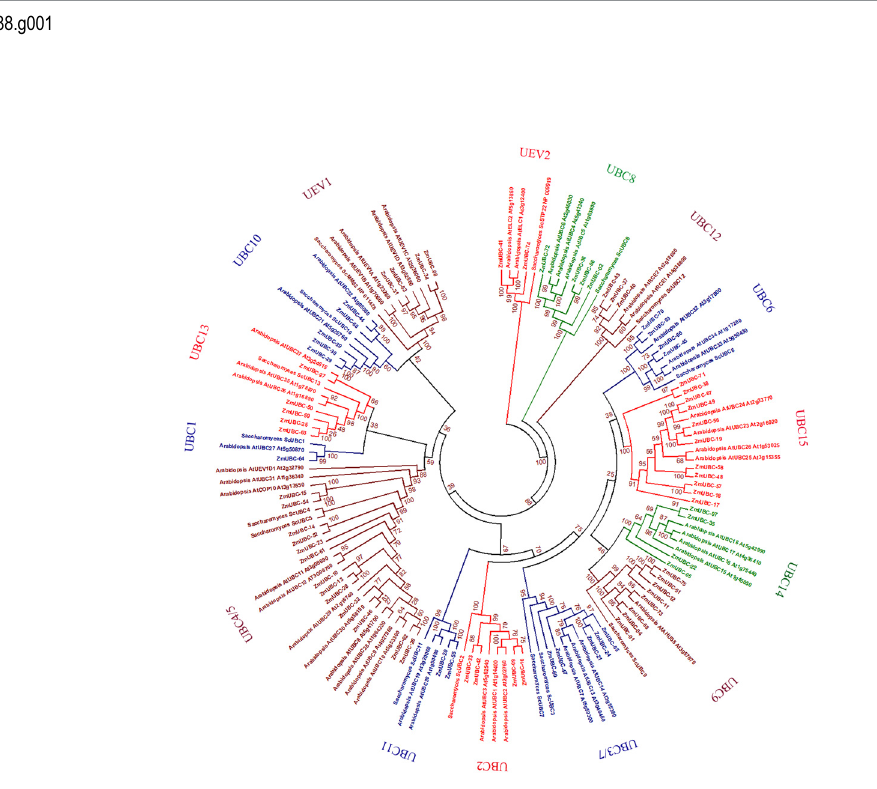
Fig 2. Phylogenetic relationship of various ZmE2s. The ML tree includes 75 UBC proteins from Zea mays , 15 from Saccharomyces cerevisiae , and 48 from Arabidopsis thaliana . The tree shows 15 phylogenetic subgroups depicted in various colors to distinguish diversification of subfamilies into